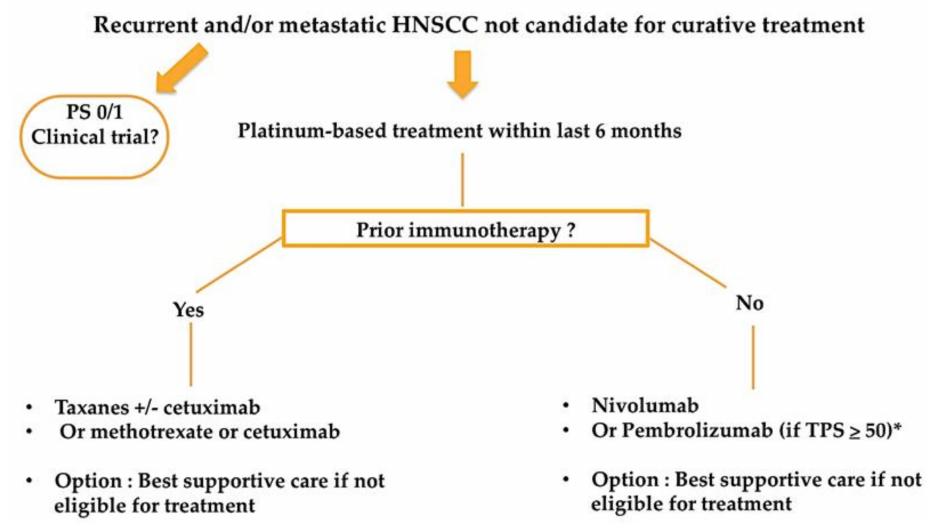
Figure 2. Proposed treatment algorithm in the second-line setting for patients with recurrent and/or metastatic HNSCC. * Patients with progression within 3 months following platinum containing chemotherapy for locoregional disease